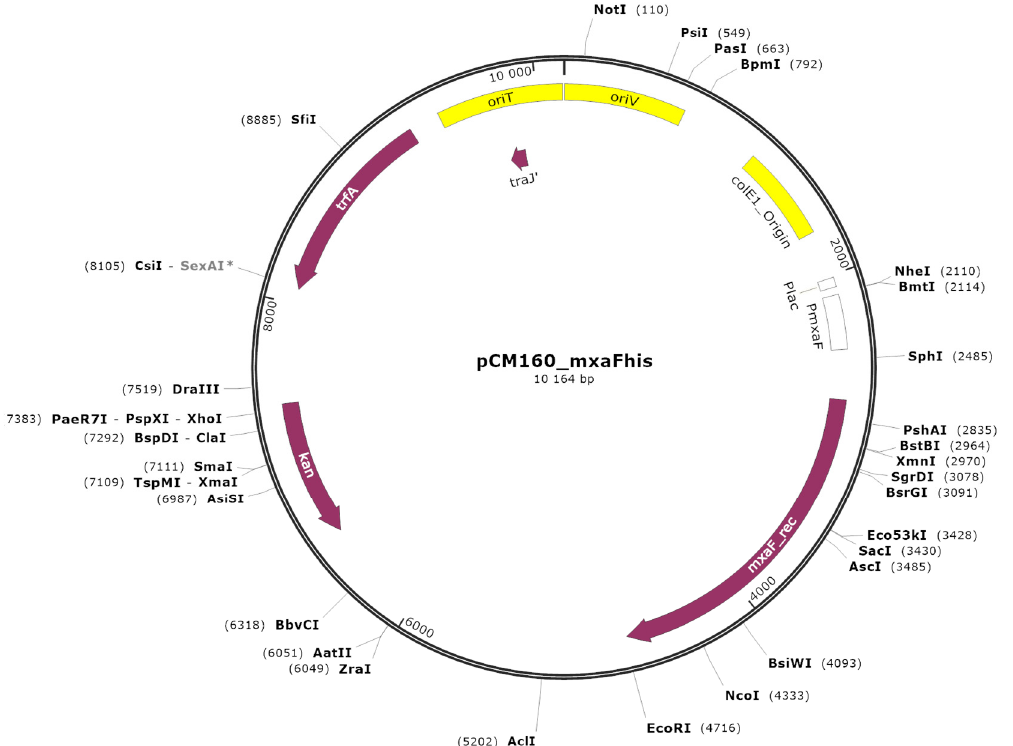
Figure 1. Genetic map of the expression vector with mxaF gene from Methylorubrum extorquens AM1. Amplification of DNA fragment from Methylorubrum extorquens AM1 containing